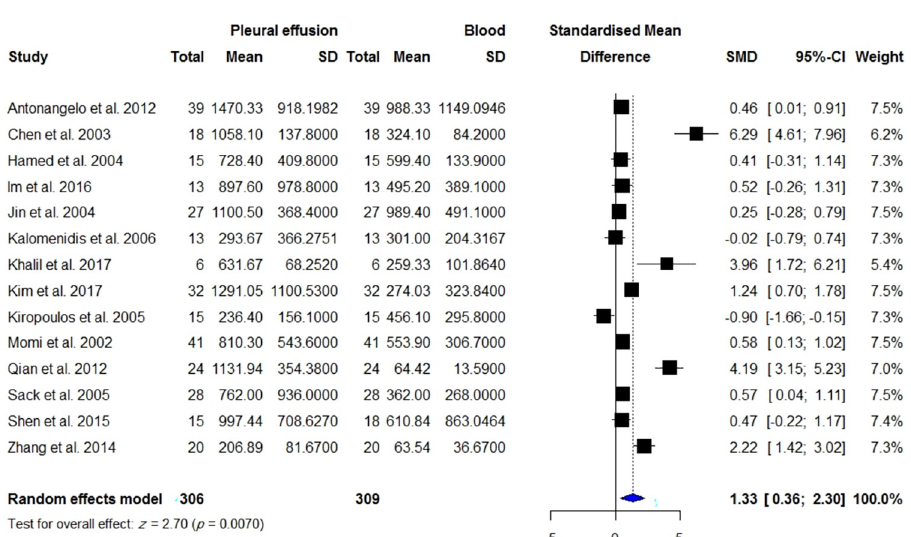
PLOS ONE | https://doi.org/10.1371/journal.pone.0268543 May 25,